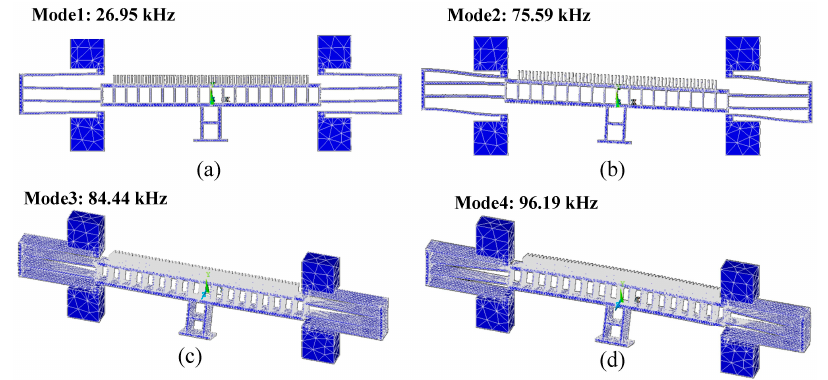
Figure 3. The first four modes of design A: ( a ) The first mode in-plane at 26.95 kHz; ( b ) The second mode in-plane at 75.59 kHz; ( c ) the third mode out-of-plane at 84.44 kHz; while ( d ) The fourth mode out-of-plane at 96.19 kHz.